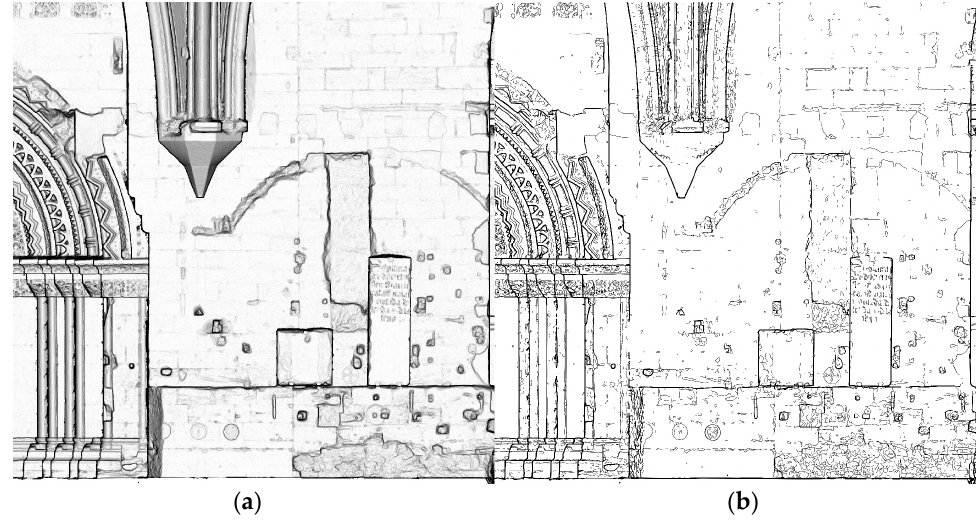
Figure 11. Raster to vector conversion: ( a ) curvature analysis; and ( b ) vector planimetry from the curvature analysis.